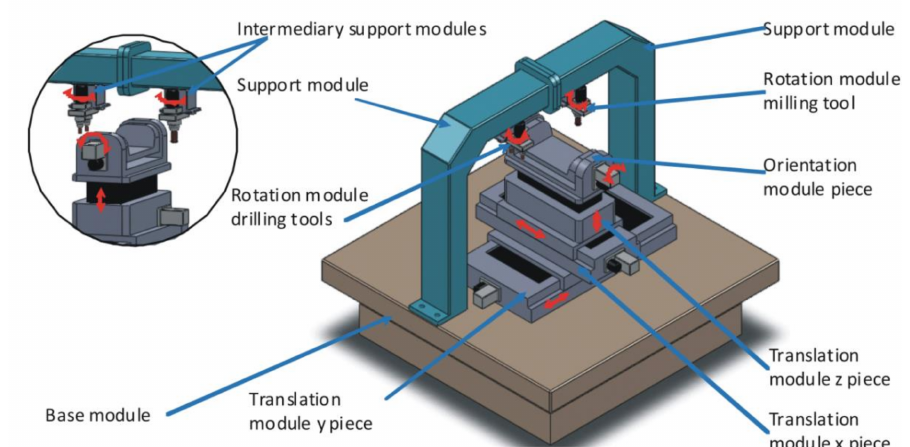
Figure 8. Particle 3 at iteration 2: variant